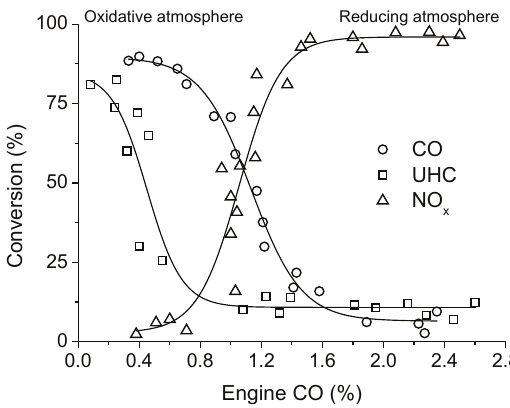
at 655–685 °C and 18,000–21,500 h − 1 as a function 3